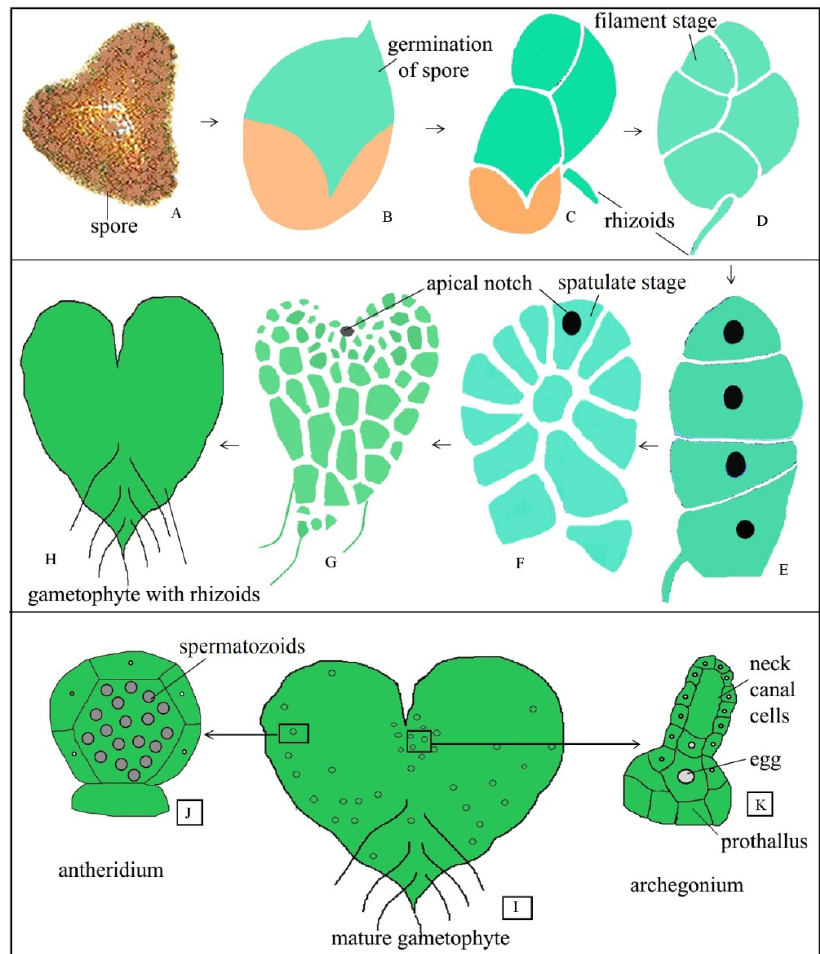
Fig. 3 Diagrammatic representation depicting stages of gametophyte formation ( Adiantum sp.) from spore germination to prothallus formation with sex